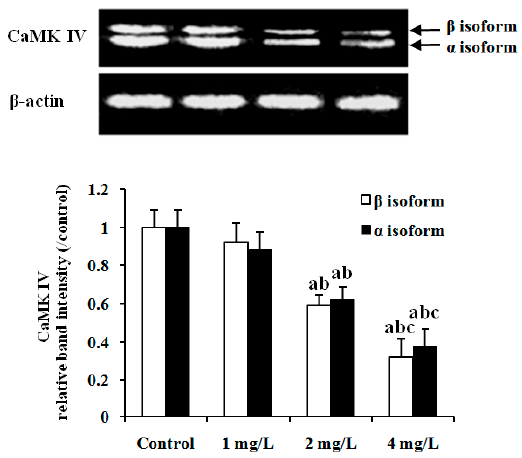
Figure 5. Effect of As exposure on protein expression of CaMK IV in cerebellar tissue of mice. Adult male mice exposed to 0, 1, 2, and 4 mg/L As 2 O 3 in drinking water for 60 days. After the treatment, the expression of CaMKIV protein was analyzed by western blot. The relative CaMK IV protein abundance was determined by the ratio of sample to β -actin. Data obtained from six separate analyses are expressed as mean ± SD ( n = 6 for each group). The double bands corresponded to α and β isoforms of CaMK IV protein, respectively. a p < 0.05 significantly different compared with the control group; b p < 0.05 significantly different compared with the 1 mg/L As 2 O 3 -treated group; c p < 0.05 significantly different compared with the 2 mg/L As 2 O 3 -treated group.